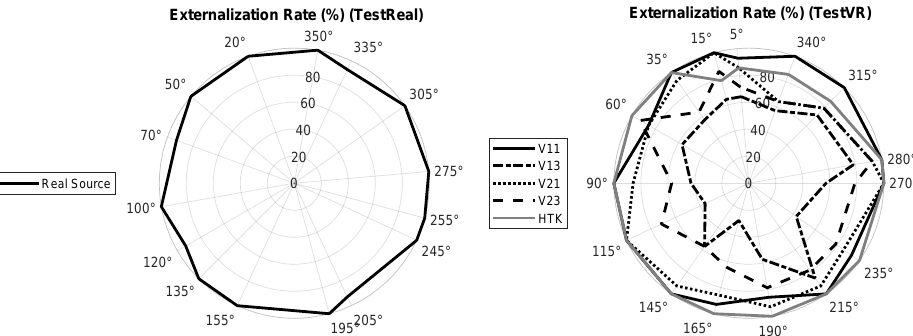
Figure 8. Externalization rate, defined as the percentage of responses classified as externalized, when localizing real sources in TestReal (Real Source) and virtual sources in TestVR (generated with V11, V13, V21, V23 and HTK).